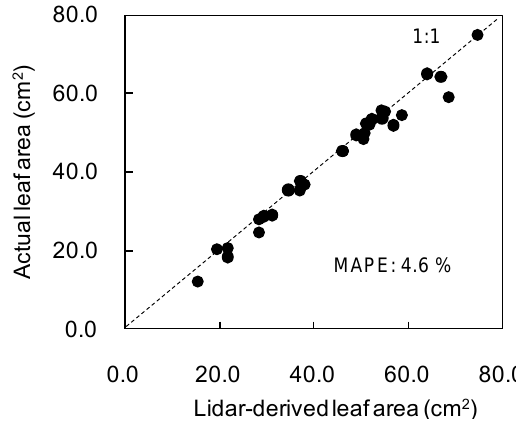
Figure 5. Comparison between leaf areas estimated from lidar-derived polygon leaf images and actual leaf areas. MAPE: Mean Absolute Percent